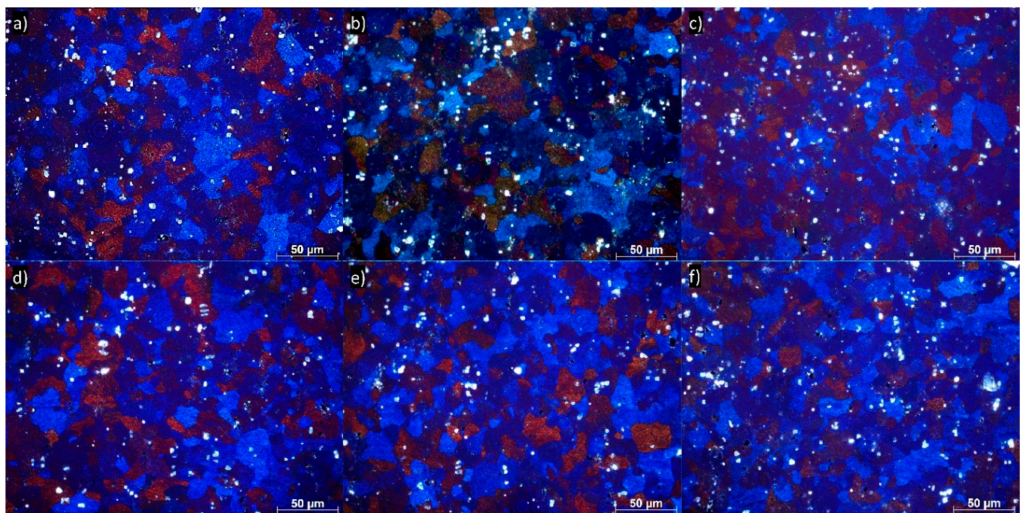
Figure 4. Examples of grain structures of 5754 aluminum alloy subjected to ( a ) one DRECE pass, ( b ) two DRECE passes, ( c ) three DRECE passes, ( d ) four DRECE passes, ( e ) five DRECE passes, ( f ) six DRECE